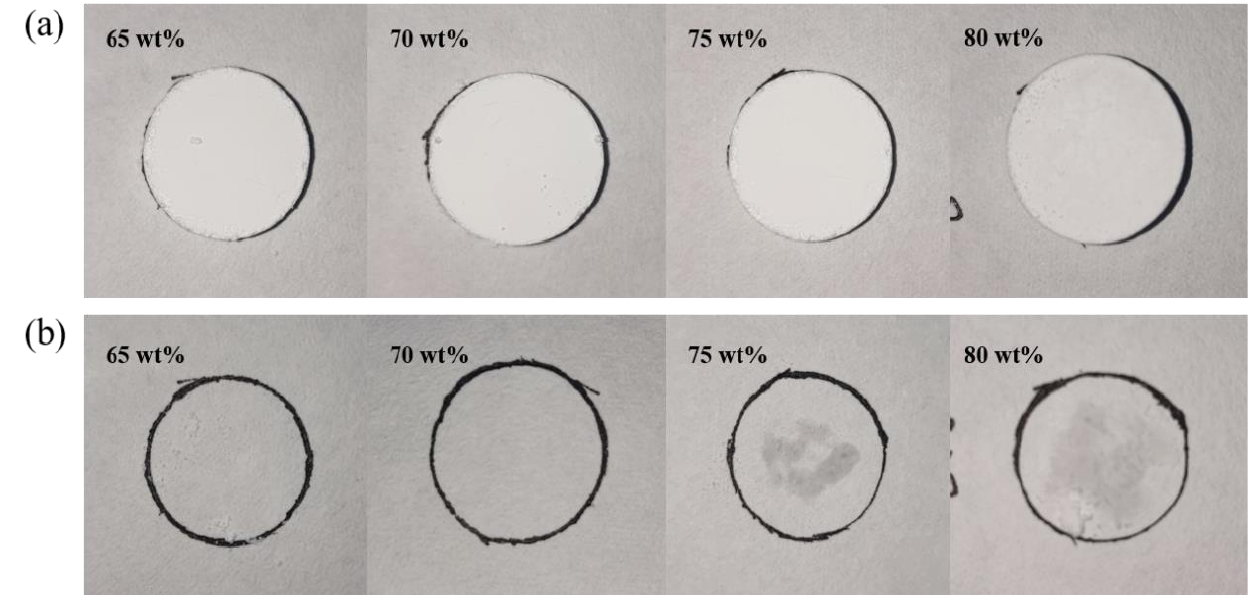
Figure 3. Liquid leakage test of composite PCMs: ( a ) before heating; ( b ) after heating.